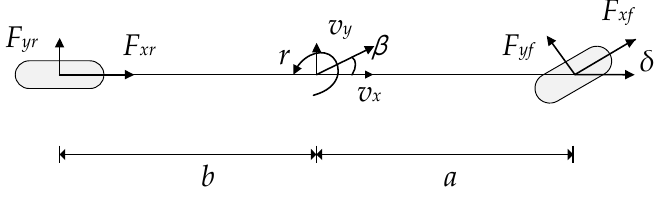
Figure 4. Single-track vehicle dynamic